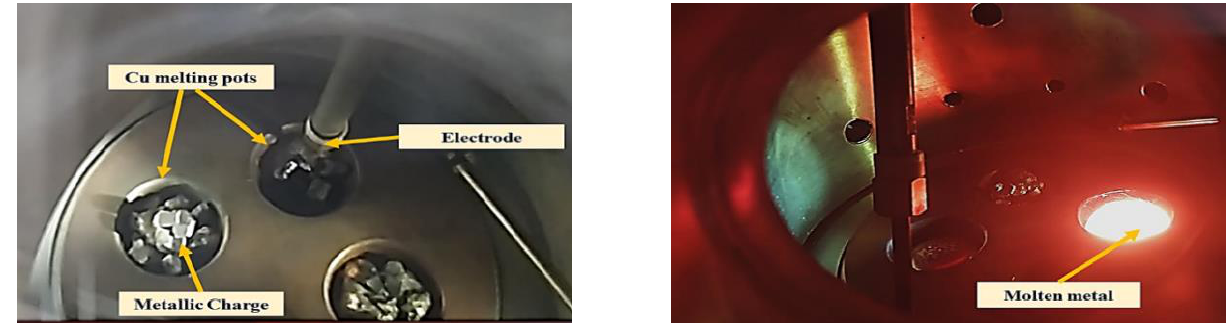
Figure 3. Placing the charge into the melting pot in the vacuum arc furnace. Table 1. chemical composition of titanium alloys.